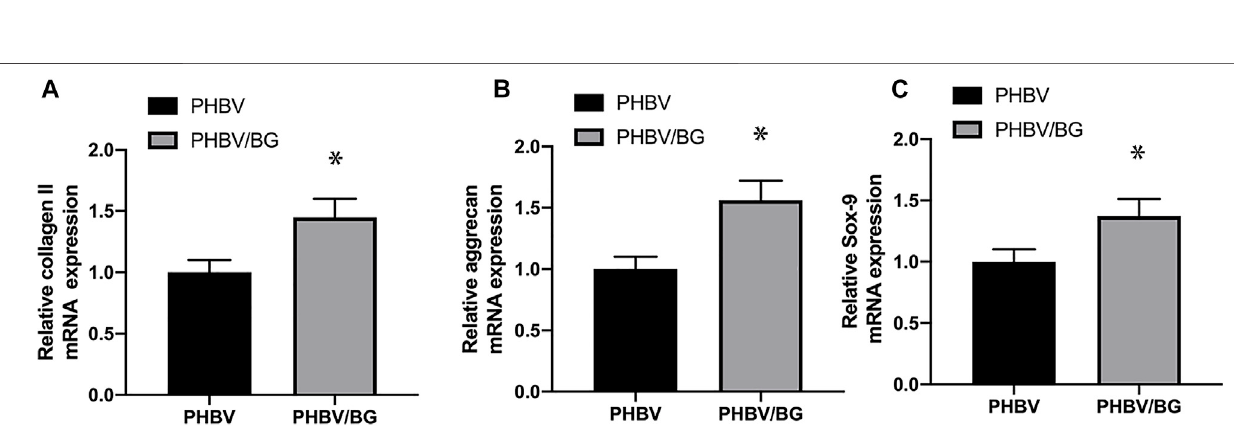
FIGURE 7 | Collagen content, GAG content, and compression modulus. There is a signi fi cant difference in terms of collagen (A) and GAG (B) contents and the compression modulus (C) between the CPC – PHBV construct and CPC – PHBV/10%Bioglass construct ( p < 0.05).